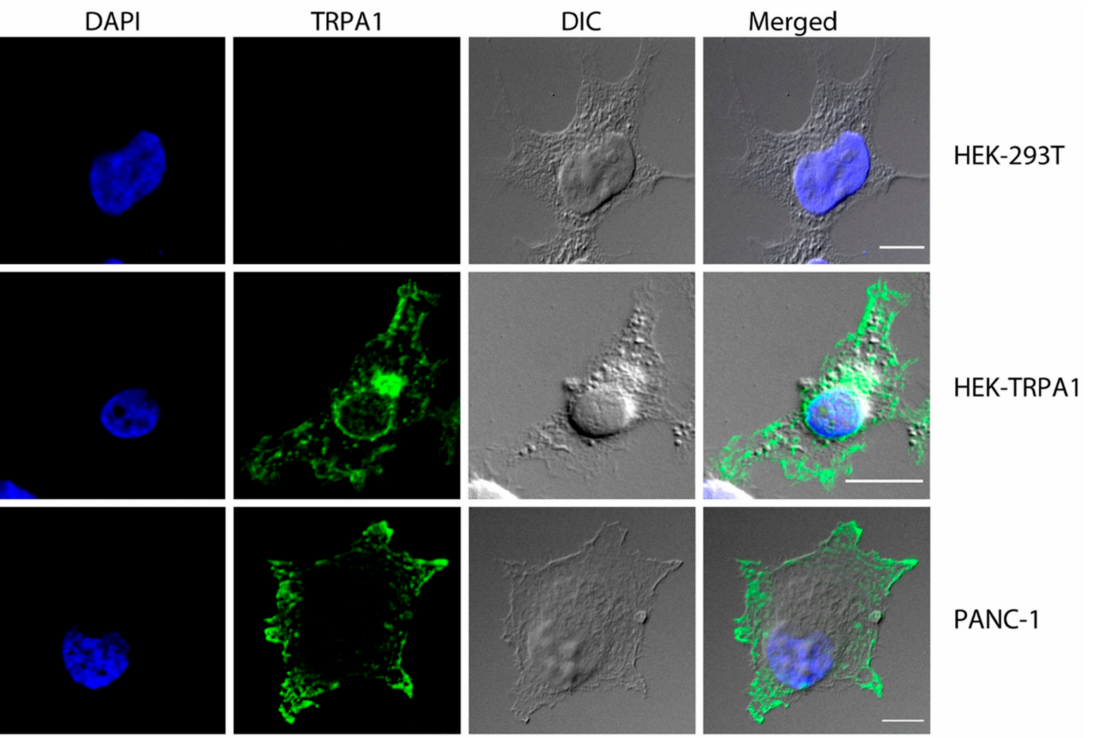
Figure 1. Expression of TRPA1 Protein in PDAC Cells: A. Immunofluorescence of fixed Panc-1 and HEK-293 T cells either transfected or un-transfected with pcDNA3.1 Plasmid encoding human TRPA1. Cells were stained with mouse monoclonal TRPA1 primary antibody (green), whereas DAPI nuclear staining is shown in blue. Scales are included in each image. Bars represent 10 µ m. Notes: Reproduced with permission from Ref. [39]. Copyright 2021 Nature